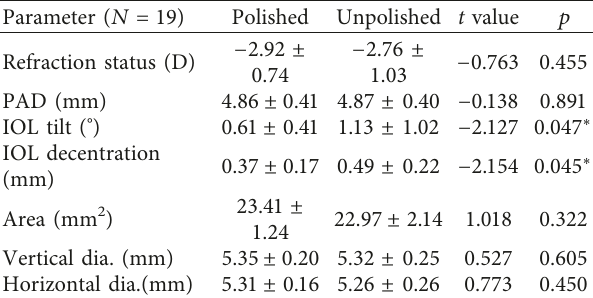
Table 3: Cross-sectional comparison between polished and un- polished groups at the 3 months after surgery.